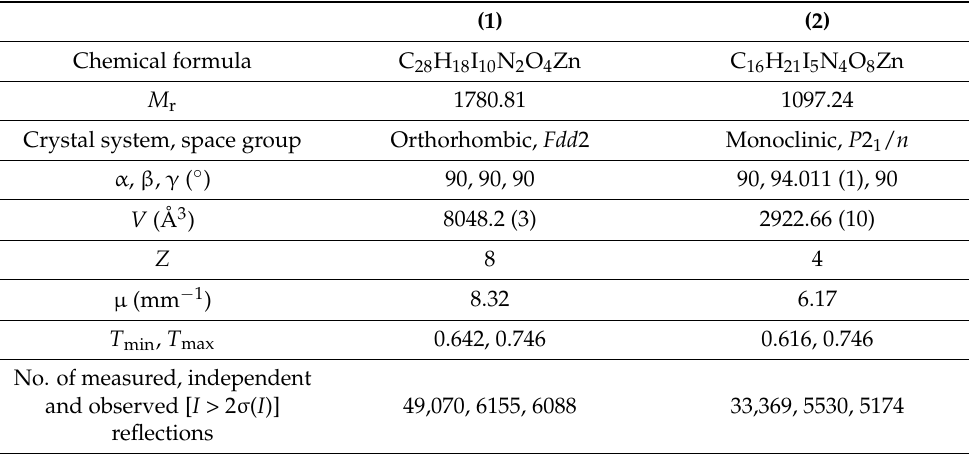
Table 1. XRD experimental